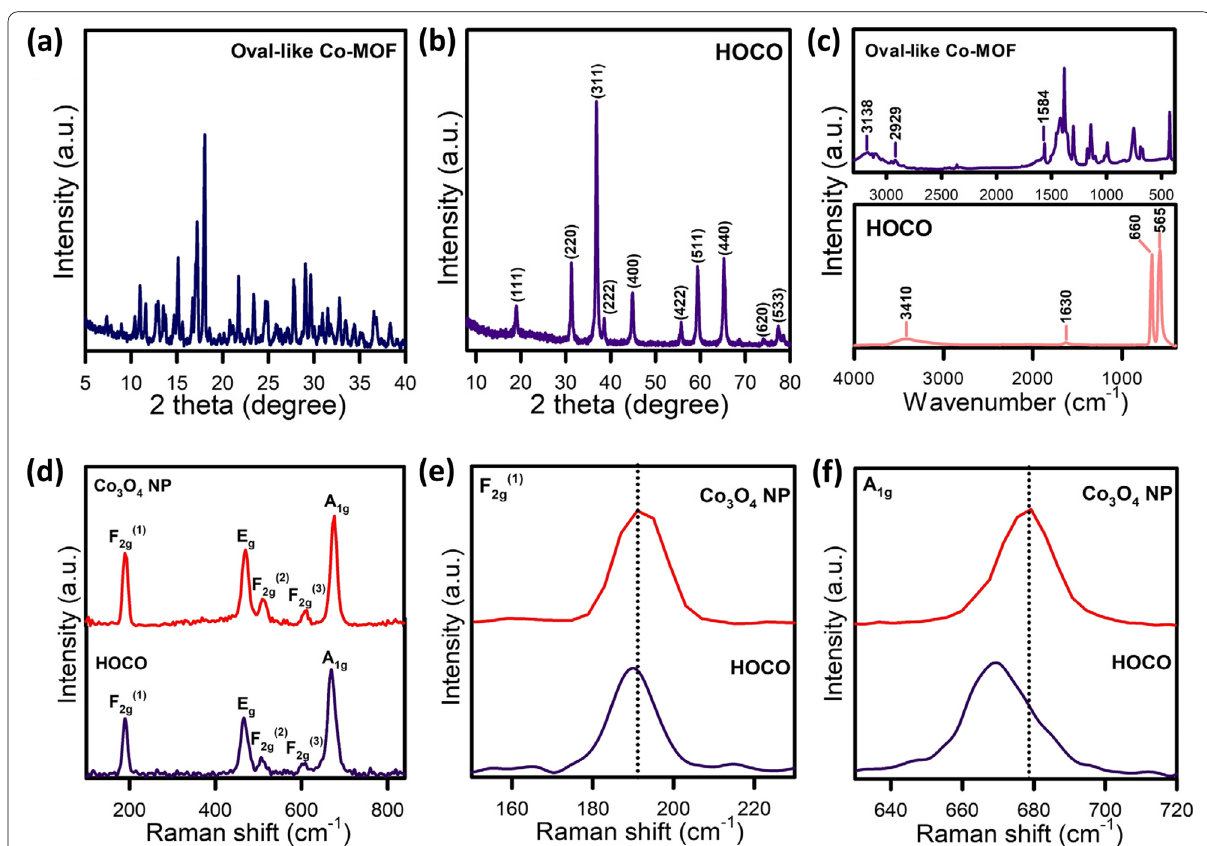
Fig. 2 ( a ) XRD pattern of the original oval‑like cobaltic MOF; ( b ) XRD pattern of HOCO; ( c ) FTIR profiles of the pristine oval‑like Co‑MOF and HOCO; ( d ) long‑range Raman spectroscopies of Co 3 O 4 NP and HOCO; ( e ) and ( f ) Raman spectroscopies at specific